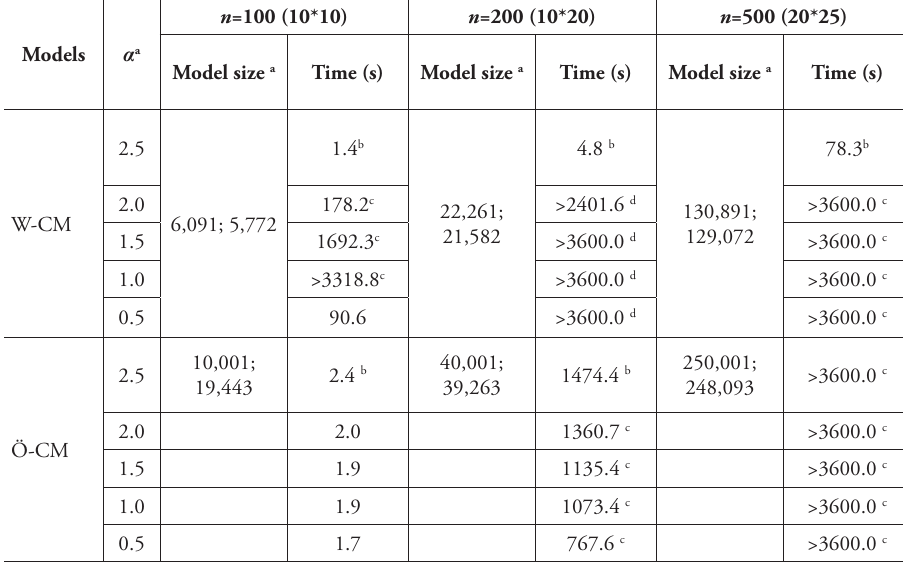
Table 4. Comparison of W-CM model and Ö-CM model in solving contiguity and compactness prob- lems with various